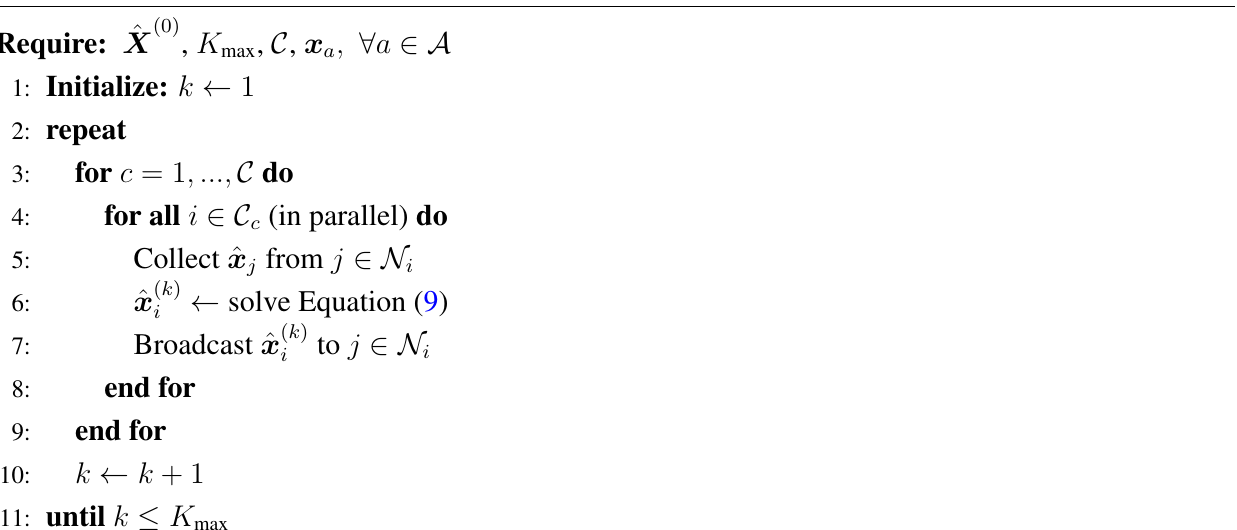
Algorithm 1 “SOCP1”: the proposed distributed second-order cone programming (SOCP) algorithm for known P T